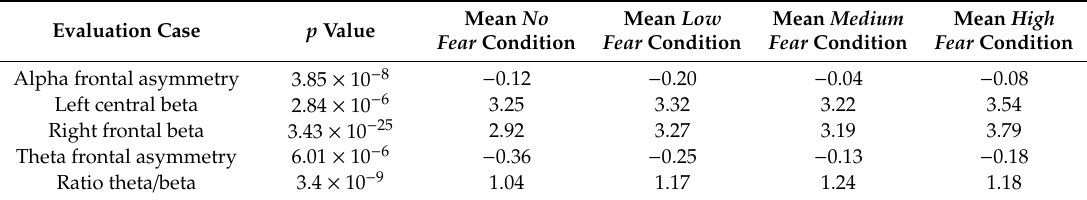
Table 9. p values and means for the four-level fear evaluation condition during the Kruskal–Wallis